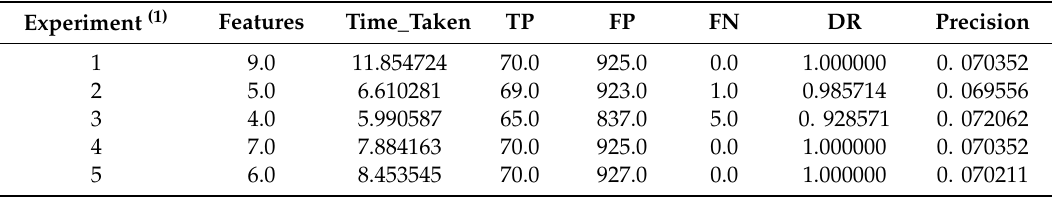
Table 6. Local outlier factor (LOF) results with feature optimization. N_neighbors = 20 and contamination = 0.1. Experiment (1)